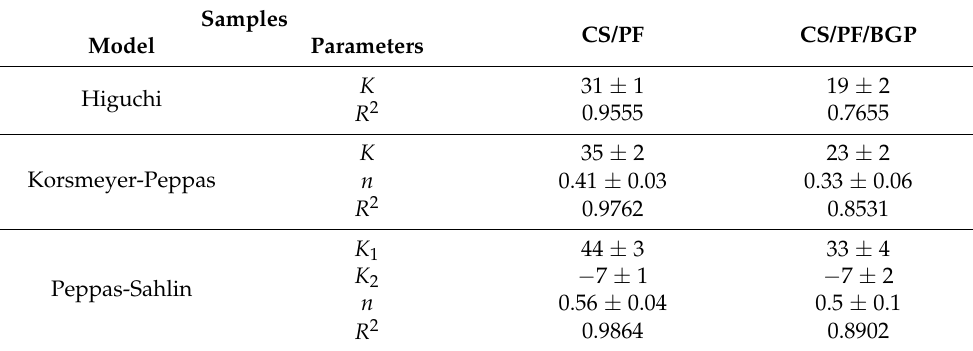
Table 1. Summary of the fit parameters to the release models for the